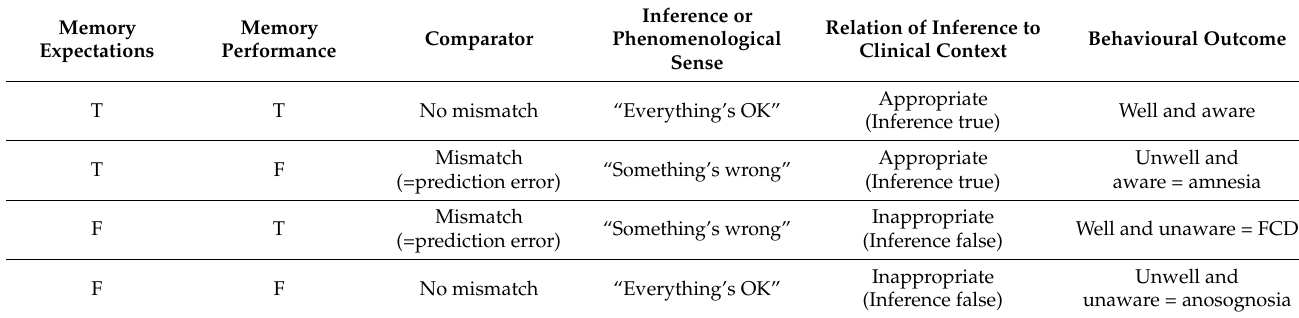
Table 1. “Truth table” for metamemory models of FCD and